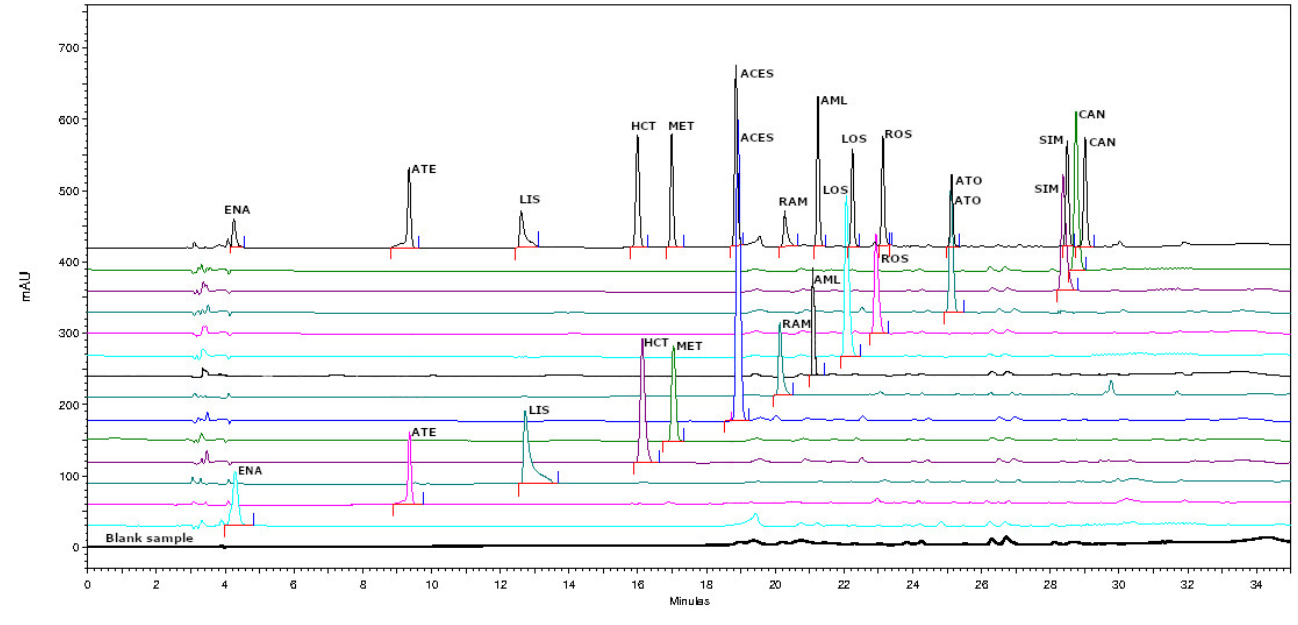
Figure 1. Overlay chromatogram of system specificity obtained from chromatograms registered for a blank sample, standards of 13 APIs, and their mixture. Table 3. System suitability parameters ( n = 5).